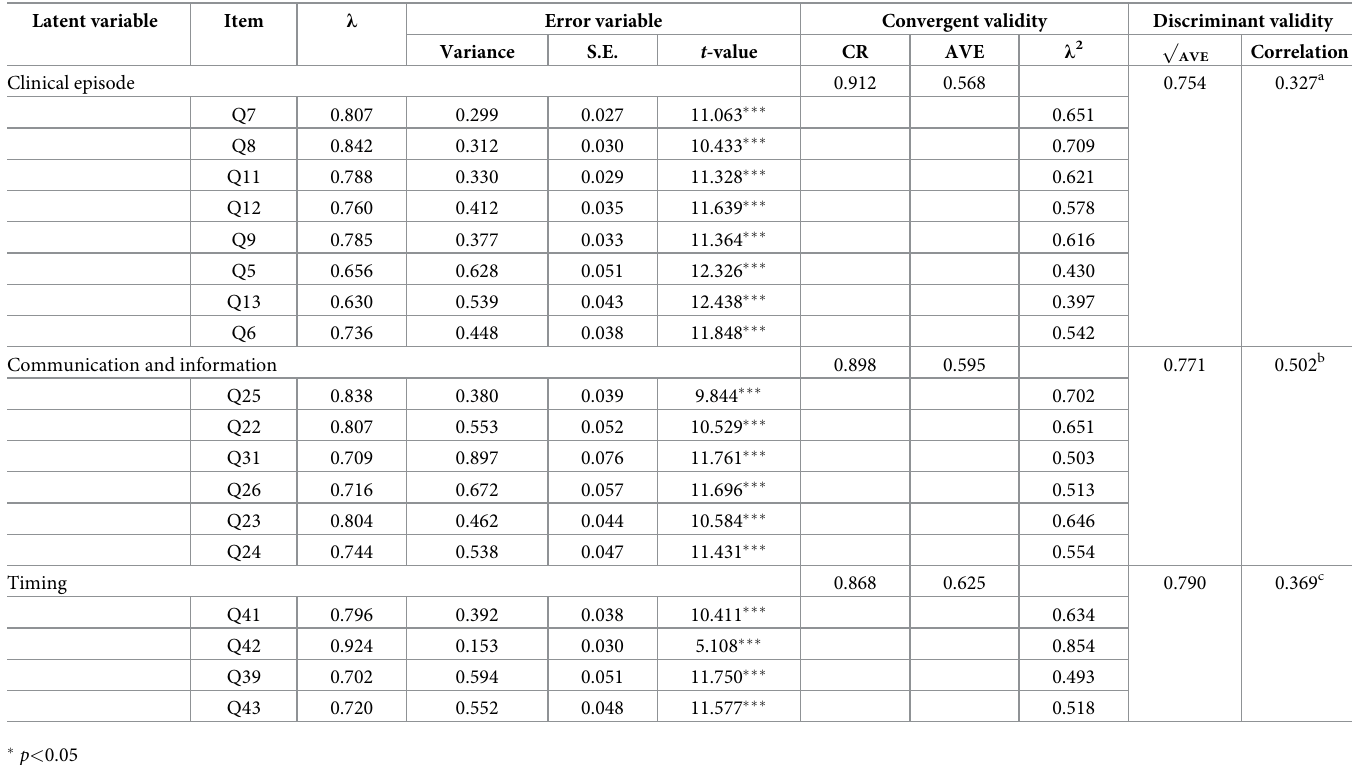
Table 4. Results of the confirmation study ( N =